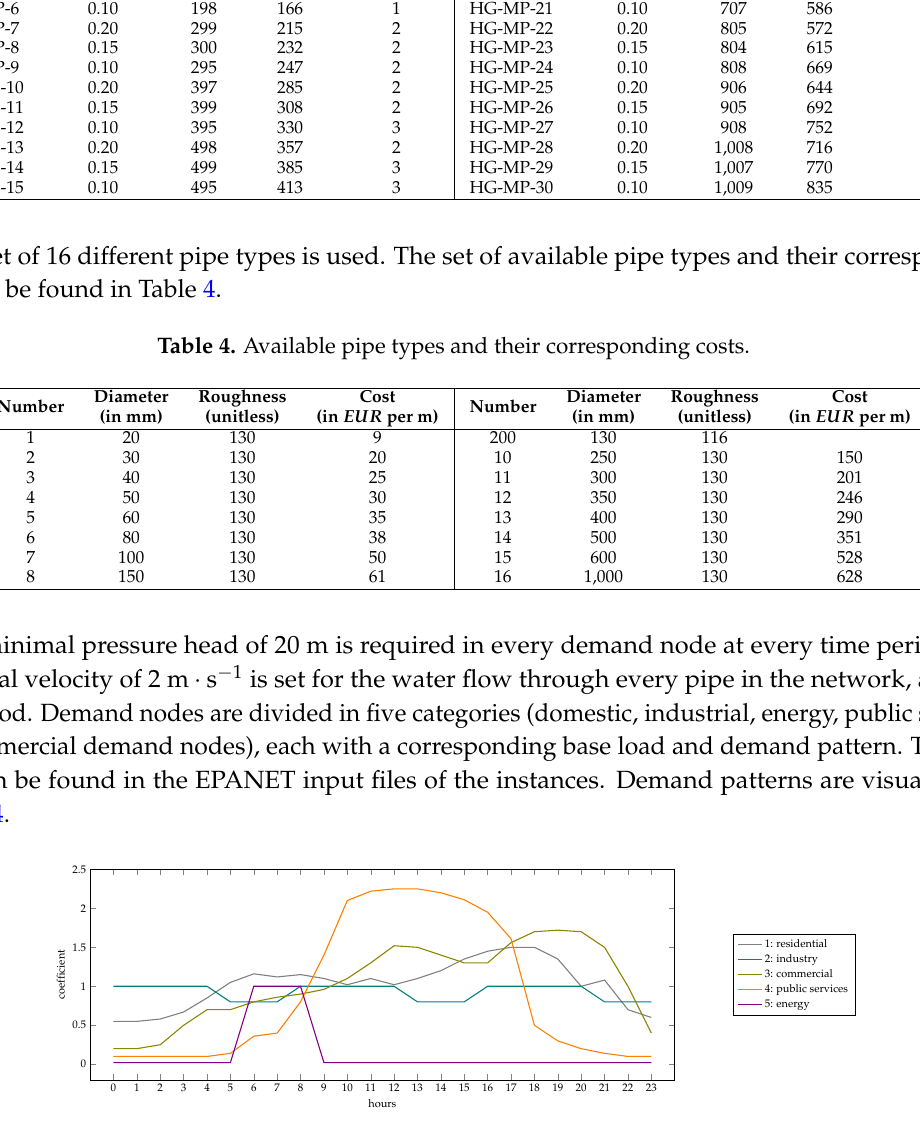
Figure 14. One-day hourly demand patterns of the predefined user